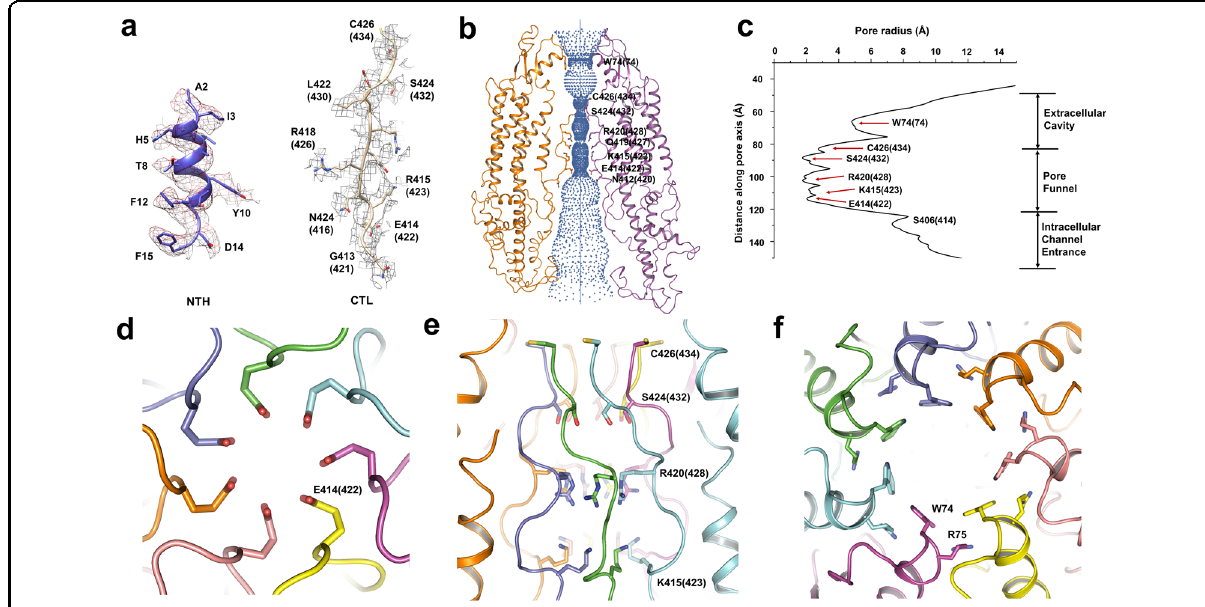
Fig. 3 Ion permeation pathway of hPANX1. a The EM density of the N terminal helix (2 – 15) and the C terminal loop (412(420) – 426(434)) with a contour level of 4 σ . b Ion permeation pathway of hPANX1 is shown along two diagonally opposed promoters using HOLE program. Ion permeation pathway contains the extracellular cavity, pore funnel, and intracellular channel entrance. W74(74), C426(434), S424(432), R420(428), Q419(427), K415 (423), E414(422), and N412(420) are shown with side chains to compose the representative gating sites. c Pore radius of the hPANX1 channel pore calculated with program HOLE. d Ribbon representation of E414(422) with each protomer color-coded. E414(422) forms a major constriction with a pore radius around 2 Å in the channel. e Ribbon representation of the C-termini of hPANX1 with each protomer color-coded. Moderate constrictions amino acids (K415(423), R420(428), S424(432), and C426(434)) are shown with side chains along the pore funnel. f Ribbon representation of the extracellular cavity of hPANX1 with each protomer color-coded. W74 and R75 are shown with side chains along the extracellular